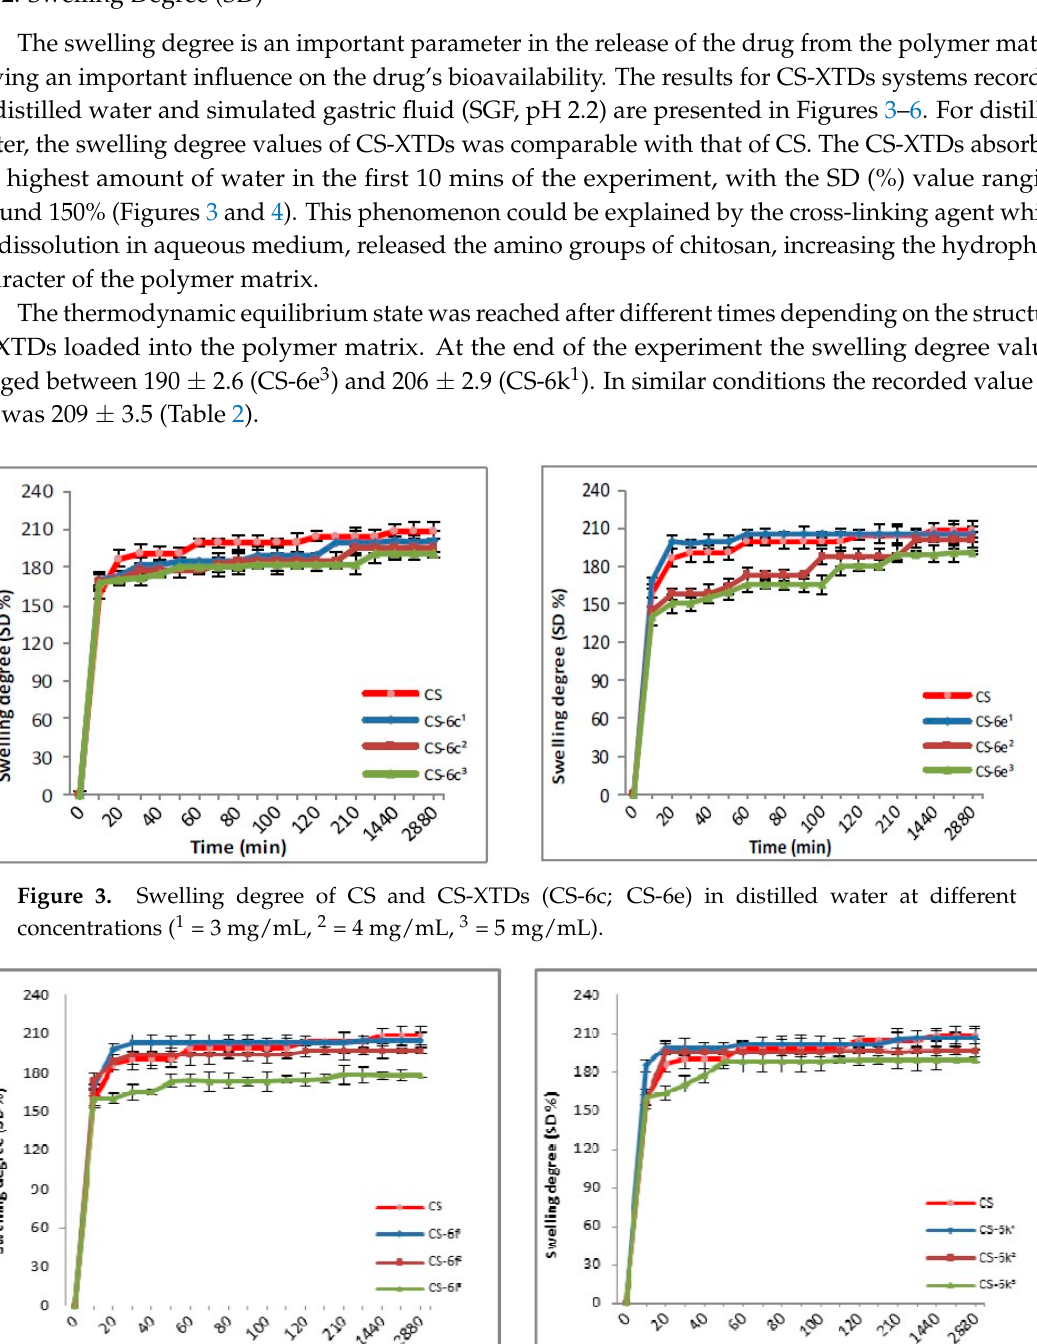
9 of 19 Figure 2. Scanning electron microscope (SEM) images for CS and CS-XTDs microparticles ( a : CS, b : CS-6c 1 , c : CS-6c 2 , d : CS-6c 3 , e : CS-6e 1 , f : CS-6e 2 , g : CS-6e 3 , h : CS-6f 1 , i : CS-6f 2 , j : CS-6f 3 , k : CS-6k 1 , l : CS- 6k 2 , m : CS-6k 3 ); 1 = 3 mg/mL, 2 = 4 mg/mL, 3 = 5 mg/mL. The results showed that a higher concentration of the cross-linking agent was associated with decreased stability of microparticles during the gelation process. Also, it was highlighted that the